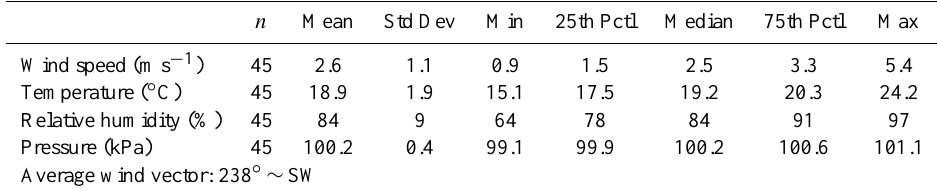
Table 1. Descriptive statistics for the daily averages of the meteorological variables obtained at the DGS during the PM 2 . 5 sampling period based upon 15min average